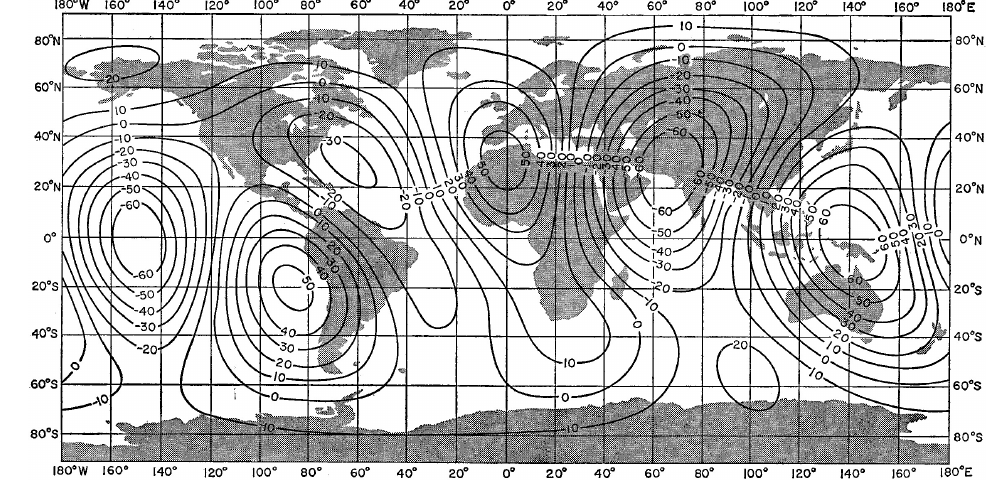
Figure 3. The Columbus geoid (Heiskanen,